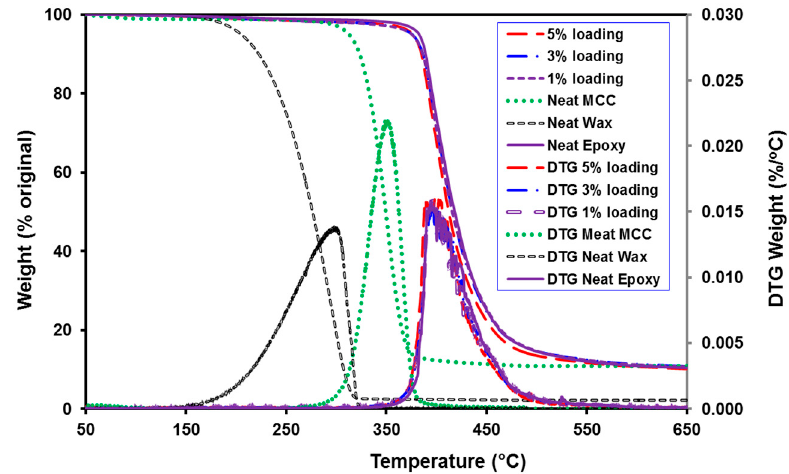
Figure 7. Thermogravimetric analysis (TGA) and their derivative thermogravimetric analysis (DTG) curves of neat MCC, neat wax, neat epoxy and EMC/Epoxy composites.